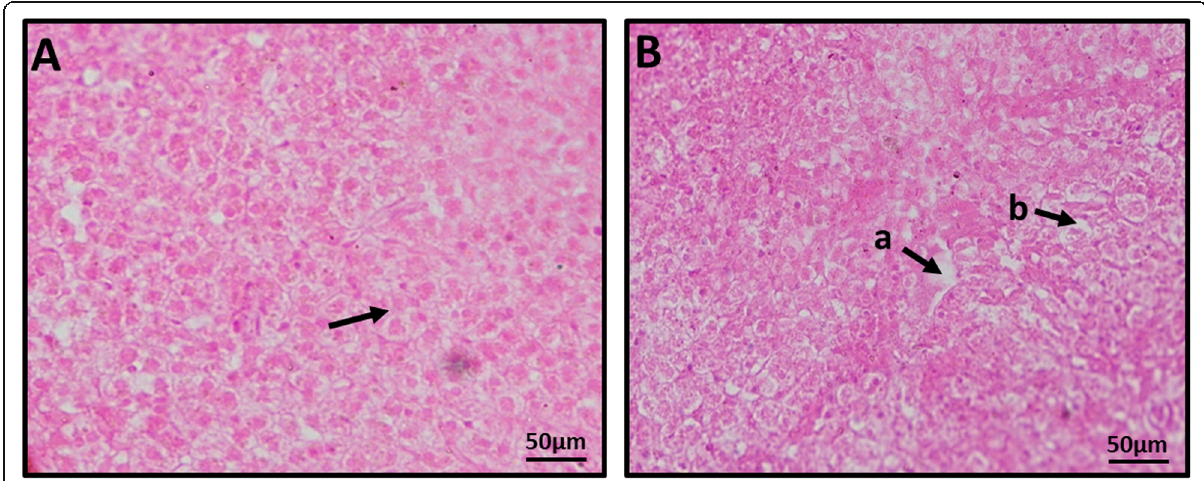
Fig. 6 Photomicrographs of liver of Heteropneustes fossilis after 7-day exposure to 0.0075 ppm Envoy 50 SC. Severe ( a ) nuclear hypertrophy and ( b ) vacuolation (a) and cytoplasmic vacuolation (b) were